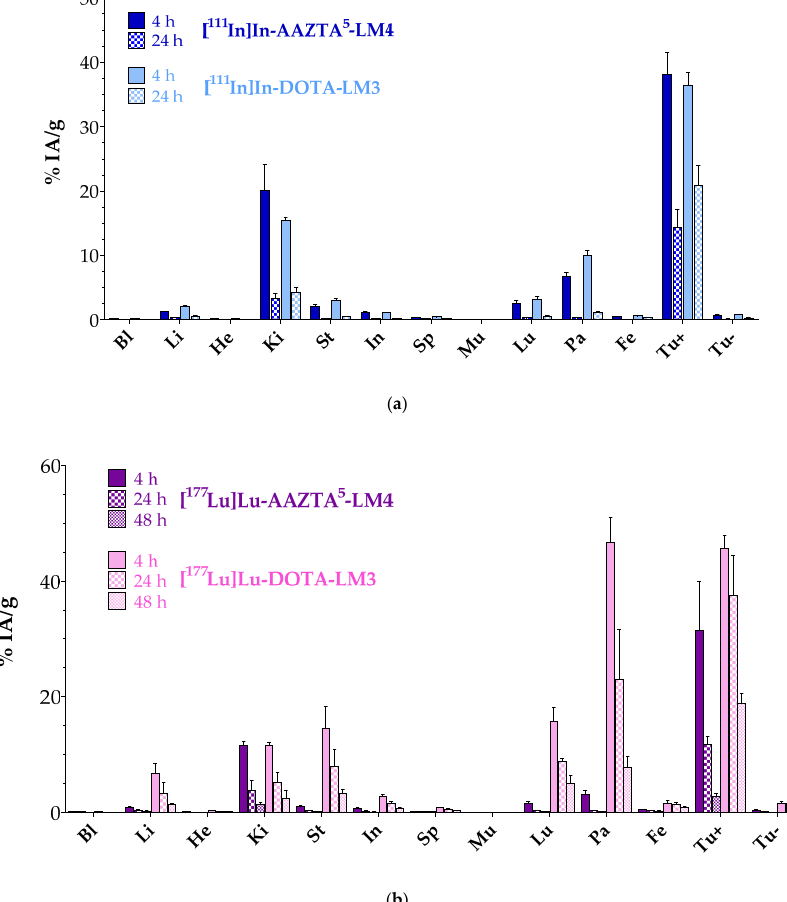
Figure 4. Comparative biodistribution data in SCID mice bearing twin HEK293 ‐ SST 2 R and wtHEK293 xenografts. ( a ) , [ 111 In]In ‐ AAZTA 5 ‐ LM4 and , [ 111 In]In ‐ DOTA ‐ LM3; ( b ) , [ 177 Lu]Lu ‐ AAZTA 5 ‐ LM4 and , [ 177 Lu]Lu ‐ DOTA ‐ LM3; solid bars for 4 h pi, checkered bars for 24 h pi and crossed bars for 48 h pi. Data are expressed as %IA/g and shown as average values ± sd, n = 4; Bl: blood, Li: liver, He: heart, Ki: kidneys, St: stomach, In: intestines, Sp: spleen, Mu: muscle, Lu: lungs, Pa: pancreas, Fe: femur, Tu+: HEK293 ‐ SST 2 R tumor, Tu ‐ : wtHEK293 tumor.